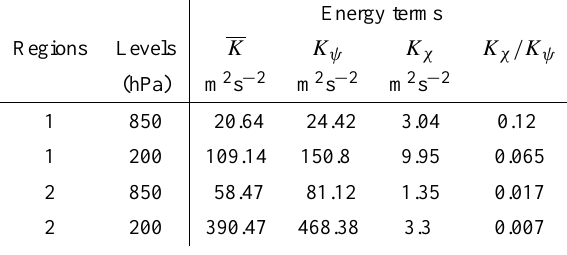
Table 1. Mean values of the kinetic energies K , K ψ and K χ , and the ratios K χ /K ψ , in areas (1) tropical and (2) extratropical South America, at levels 850 hPa and 200 hPa, for summer. Values are expressed in m 2 s − 2 Energy terms Regions Levels